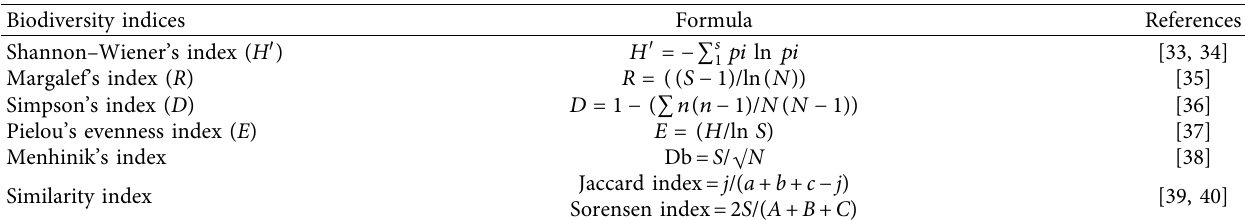
Table 3: The list of equations used for calculating biodiversity indices of the vegetation in the study